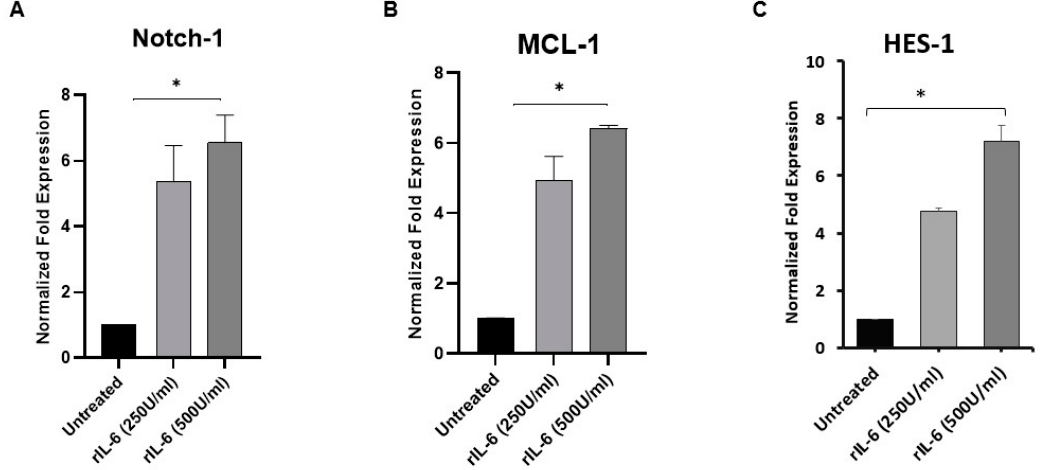
Figure 4. Effect of rIL-6 on Notch-1, MCL-1 and HES-1 expression in macrophages. THP-1-derived macrophages were treated with rIL6 (0–500 U/mL) then analyzed for the expression level of Notch-1 ( A ) MCL-1 ( B ) and HES-1 ( C ) using RT-PCR. All experiments were performed in triplets. Data are shown as mean ± SD, and significance is considered as * p < 0.05.